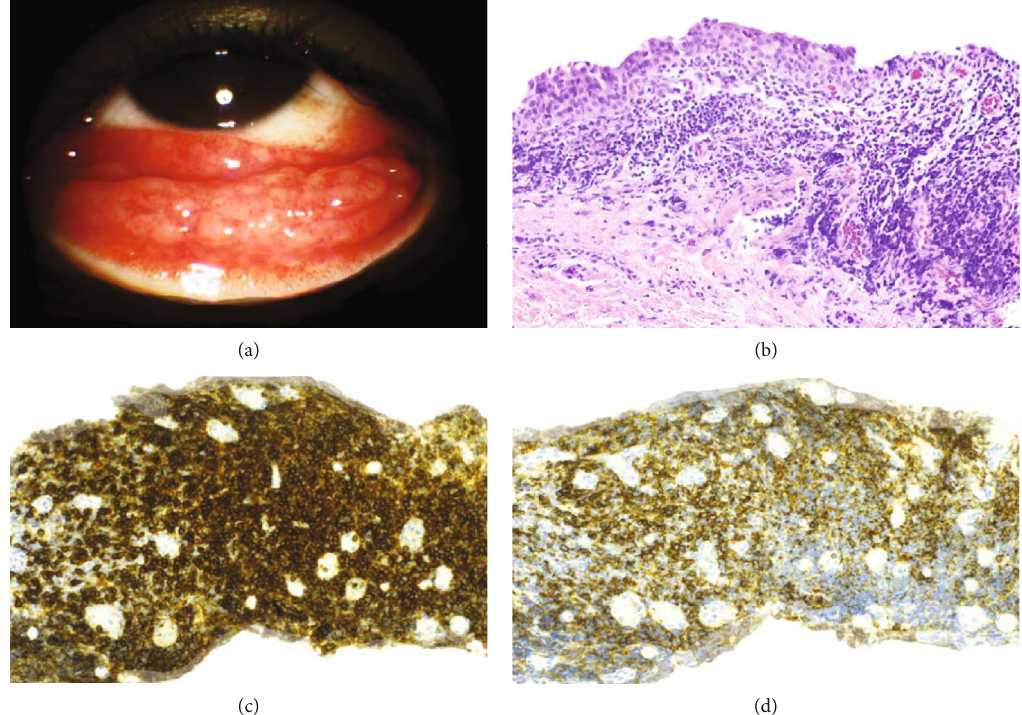
Figure 1: Clinical fi ndings show prominent follicular reaction with conjunctival mucosa (a). Microscopically, a mixed chronic in fl ammatory in fi ltrate is seen within the subepithelium (b: H&E, 20x). Immunohistochemical studies highlight a mixture of B cells (c: CD20, 20x) and T cells (d: CD3;